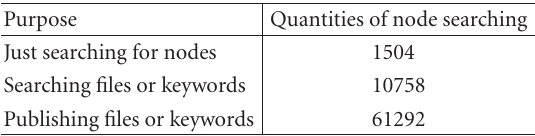
Table 2: The purpose of node searching. Purpose Quantities of node searching Just searching for nodes